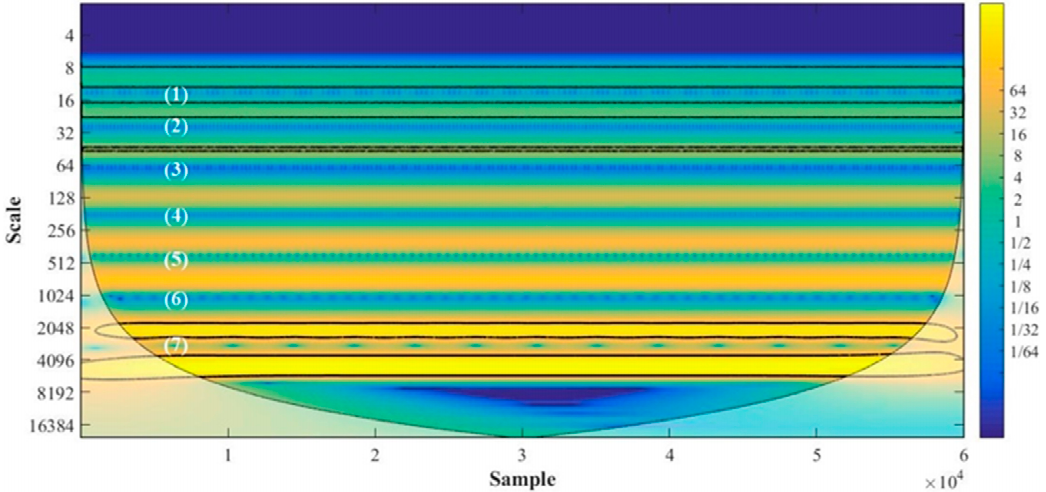
Figure 2. WT scalogram of the reference sine wave signal. The region corresponding to each component frequency interval is shown (1—first harmonic of the cardiac component; 2—cardiac; 3—respiratory; 4—myogenic; 5—sympathetic; 6—endothelial NO-dependent; 7—endothelial NO-independent).